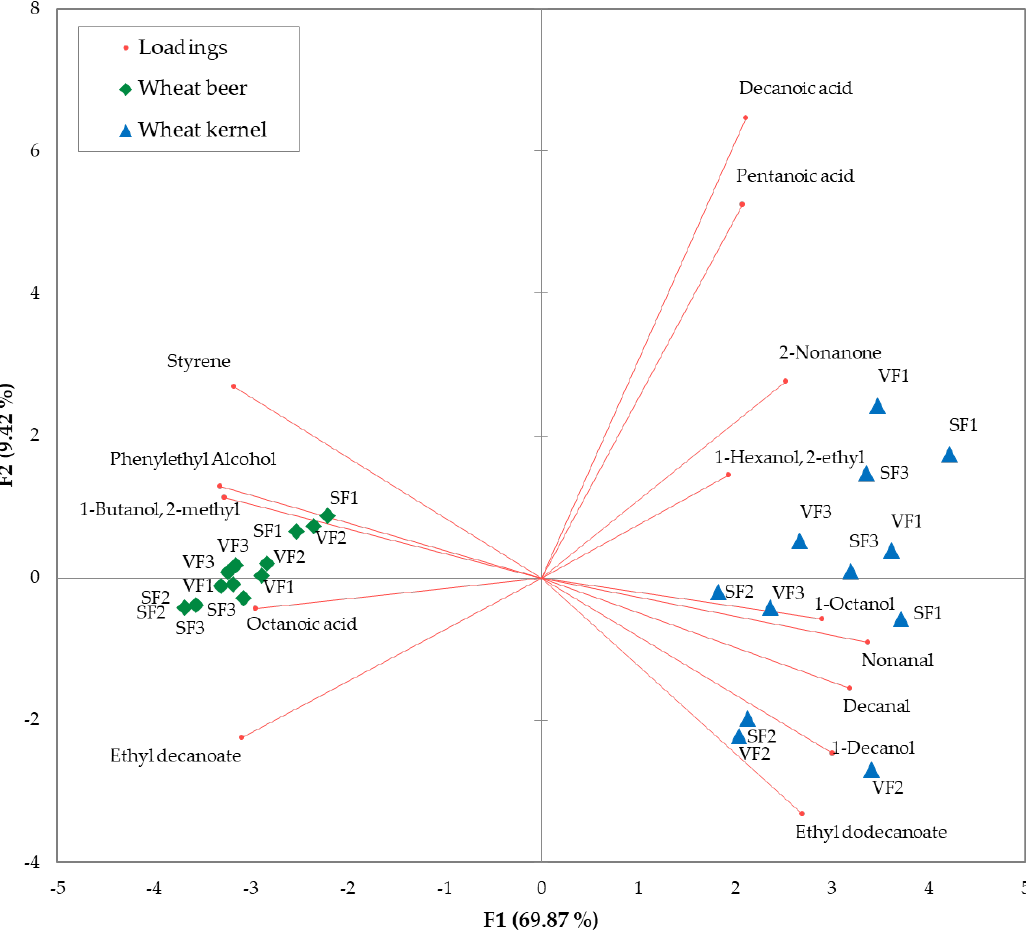
Figure 1. PCA biplot of common VOCs identified in wheat kernels and wheat beers. Score nomencla- ture: (V) Vittorio wheat; (S) Solina wheat; F1: 70 m a.s.l.; F2: 500 m a.s.l.; F3: 1200 m a.s.l.